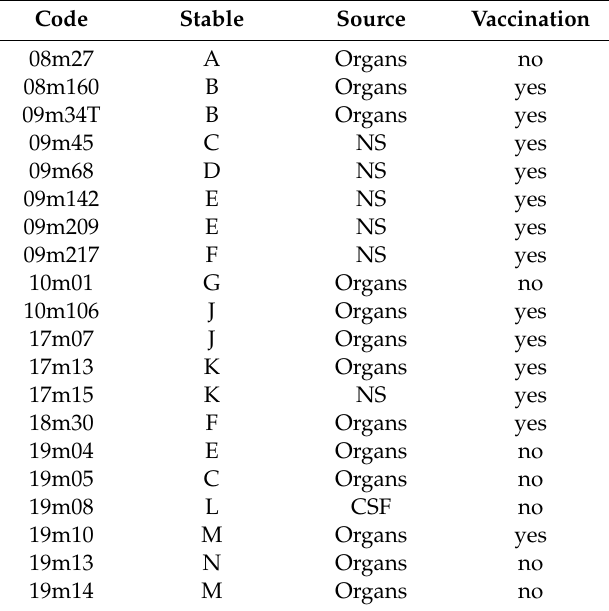
Table 1. Samples included in the